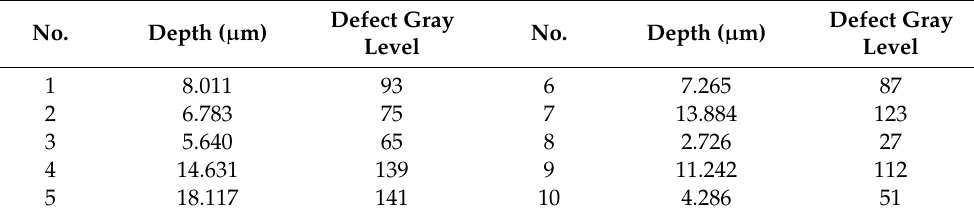
Table 1. Ten random samples out of 113.